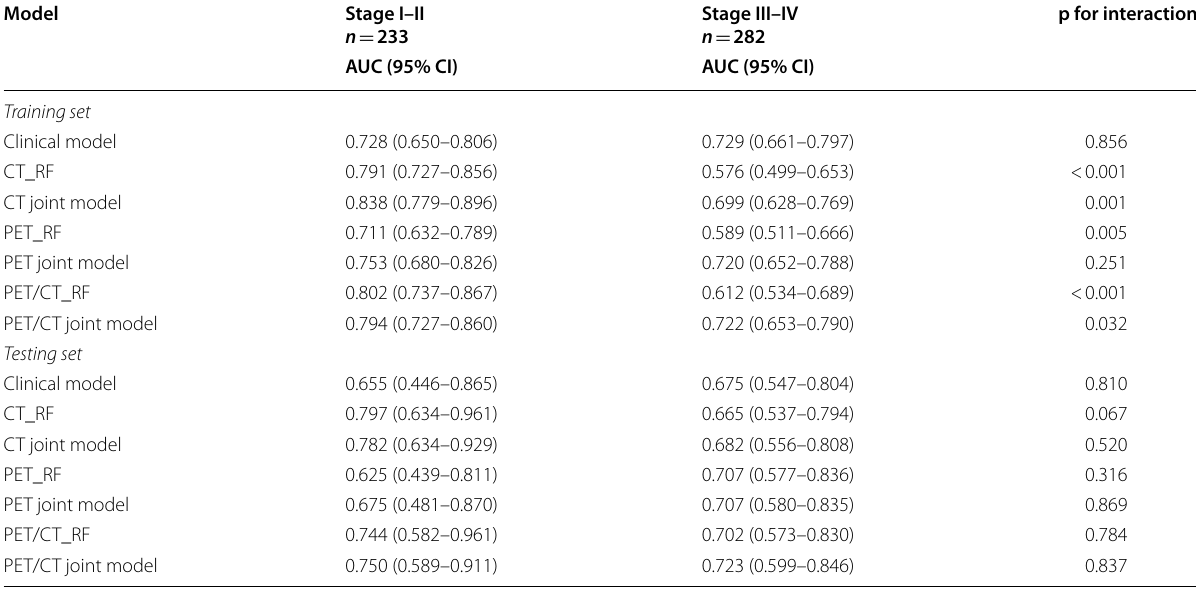
AUC area under the curve; CI confidence interval; RF random forest